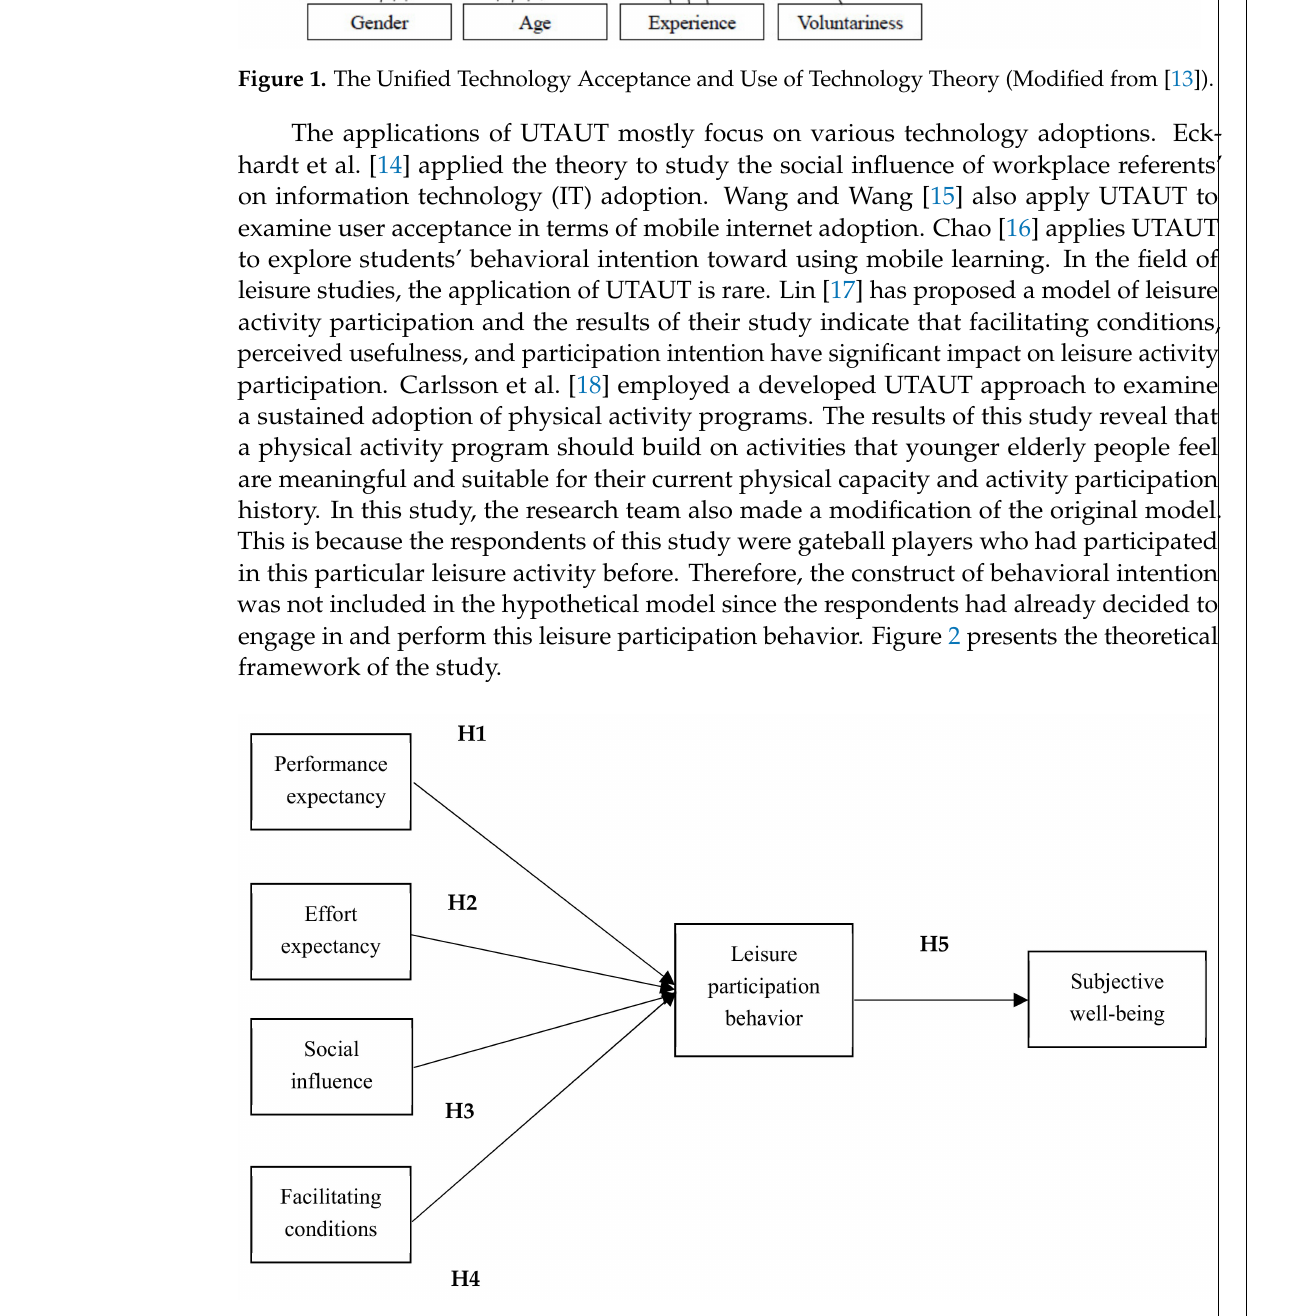
Figure 2. Concept of research